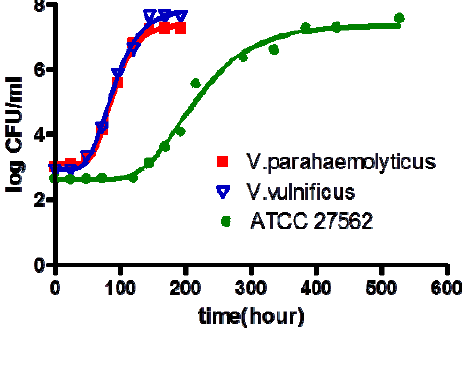
Figure 4. Comparison the growth curves of inoculated V. vulnificus and V. parahaemolyticus isolated from oyster and V. vulnificus ATCC 27562 in broth at 11 °C. Data (n = 4) were fitted using Equation